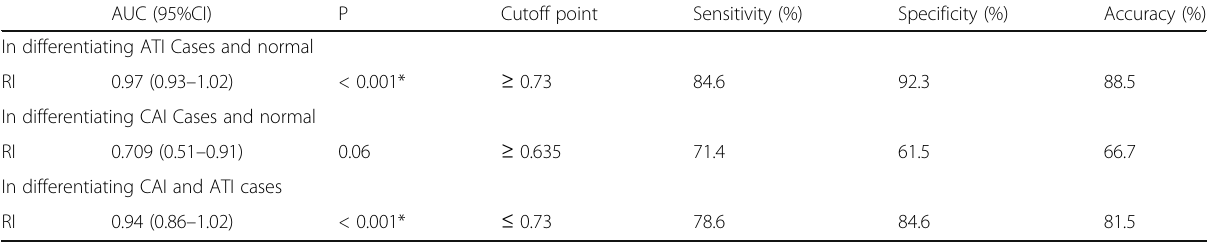
Table 6 The statically significant difference of RI between the three studied groups AUC